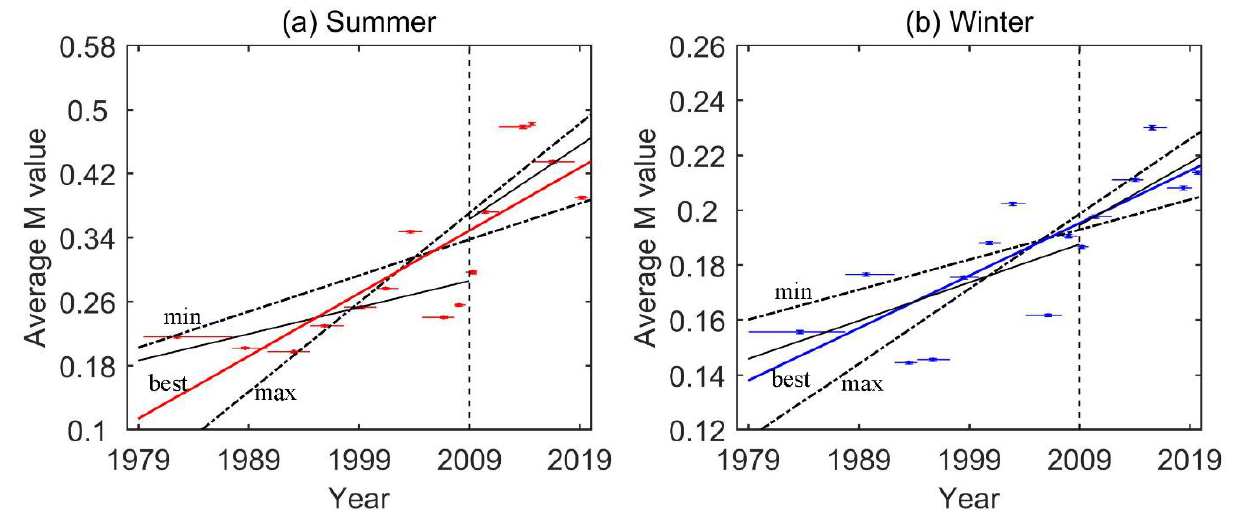
Figure 4. Multi-annual variation of sea ice inertial oscillation magnitude M(t) in ( a ) summer and ( b ) winter from January 1979 to December 2019. For each season, the data is equally divided into 15 successive bins. The mean value and error of each bin are independently estimated. The horizontal line represents the time span of each bin. The increasing rates (in the least square sense weighted by the errors) for 1979 – 2019, 1979 – 2008, and 2009 – 2019 are shown in each panel. The black dotted lines are error bounds of the rates for 1979 – 2019.